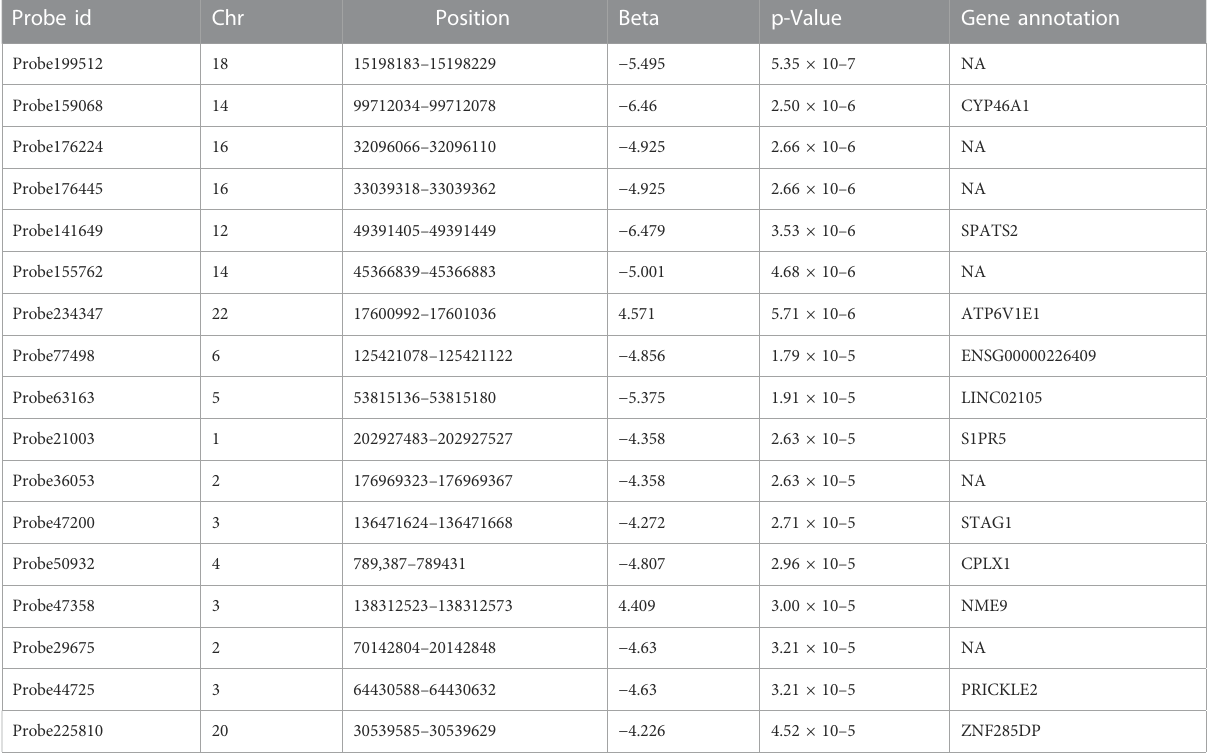
TABLE 1 Differentially methylated positions associated with antipsychotic